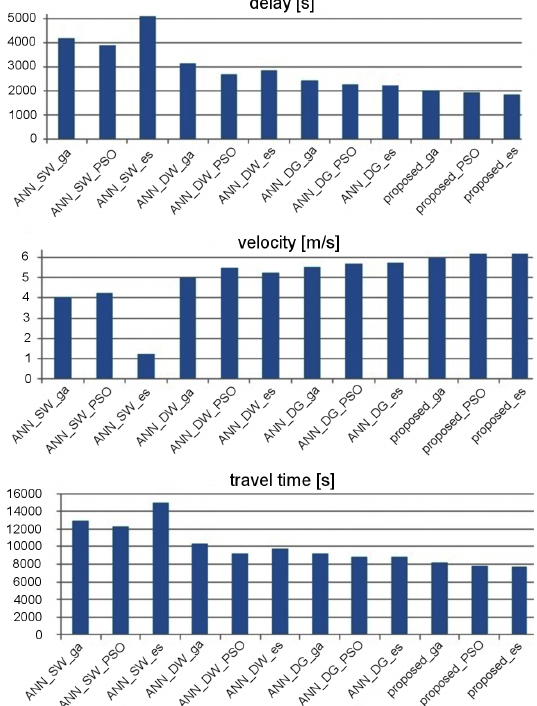
Figure 15. Effectiveness of traffic control for the considered ANNs in grid road